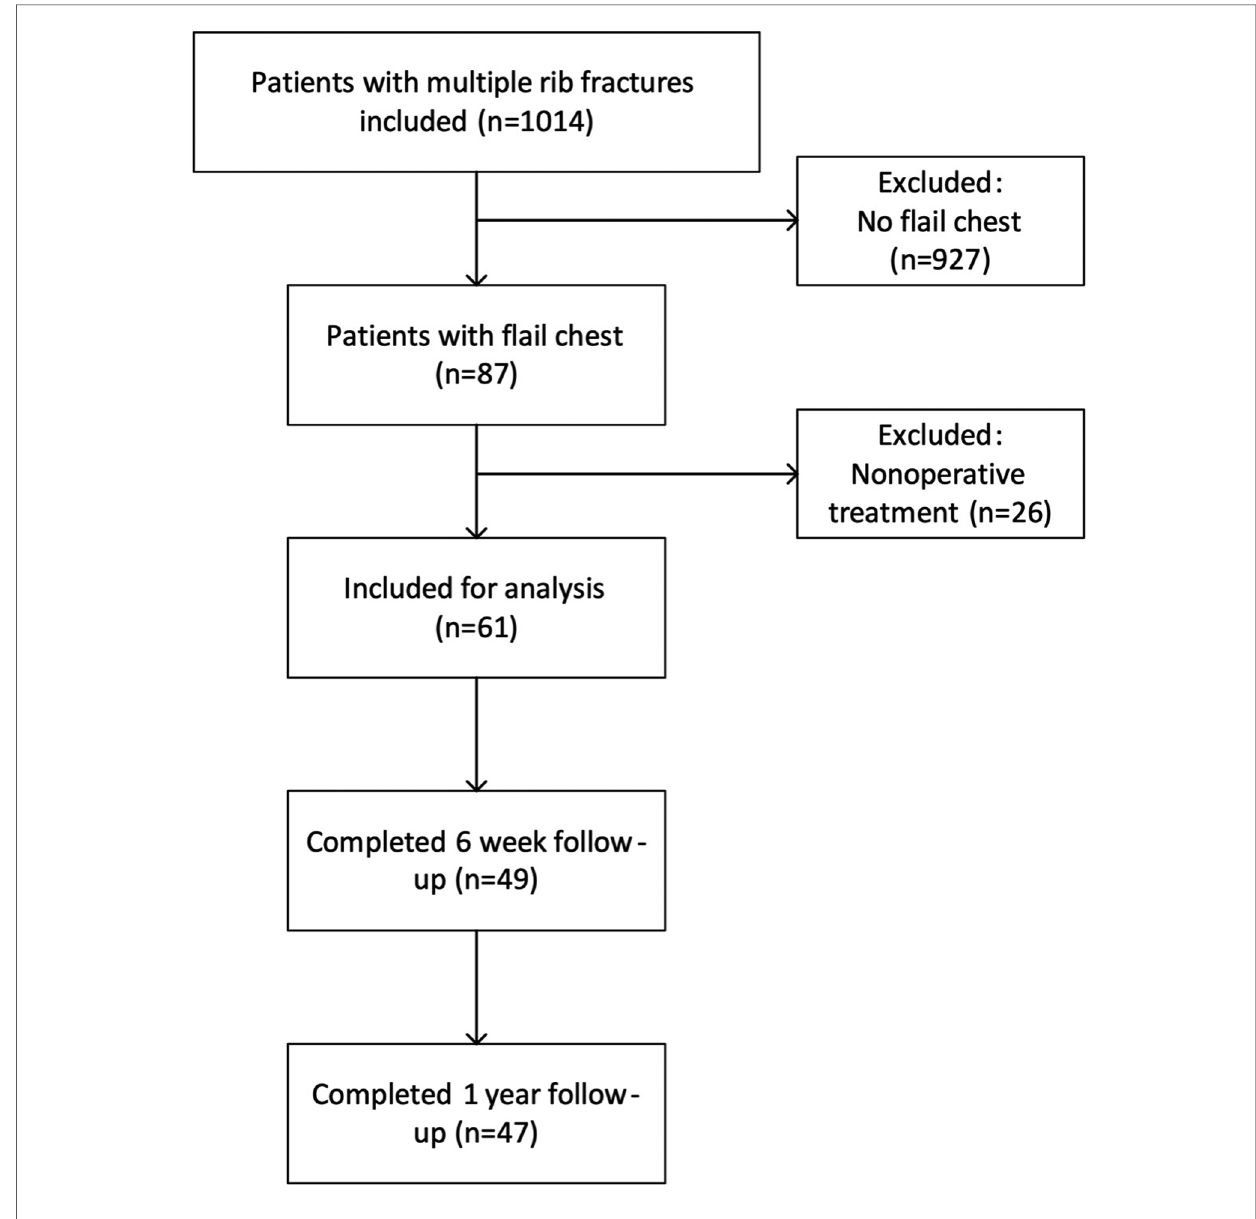
FIGURE 1 Flow diagram of inclusion and